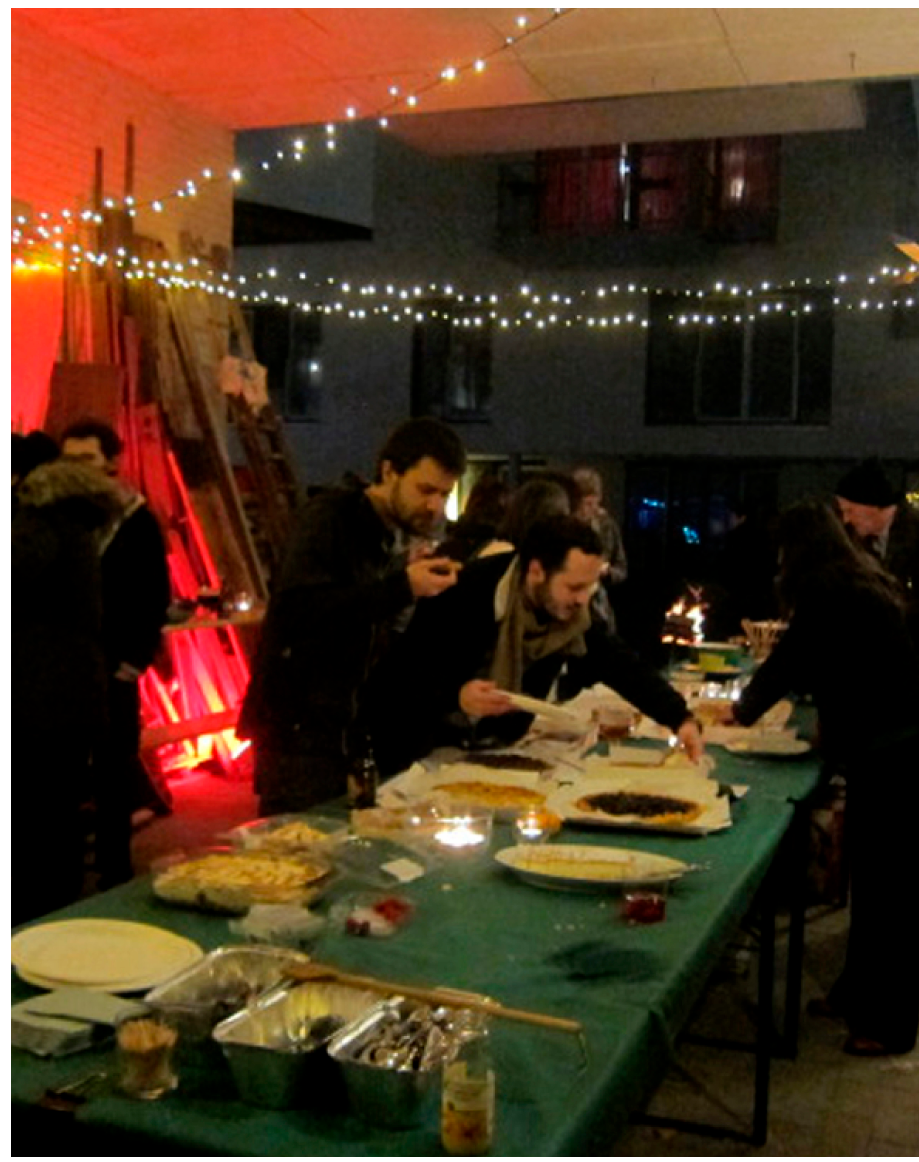
Figure 8. Community dinner in the collective room (http://www.echappee.collectifs.net, accessed on 11 June 2019)